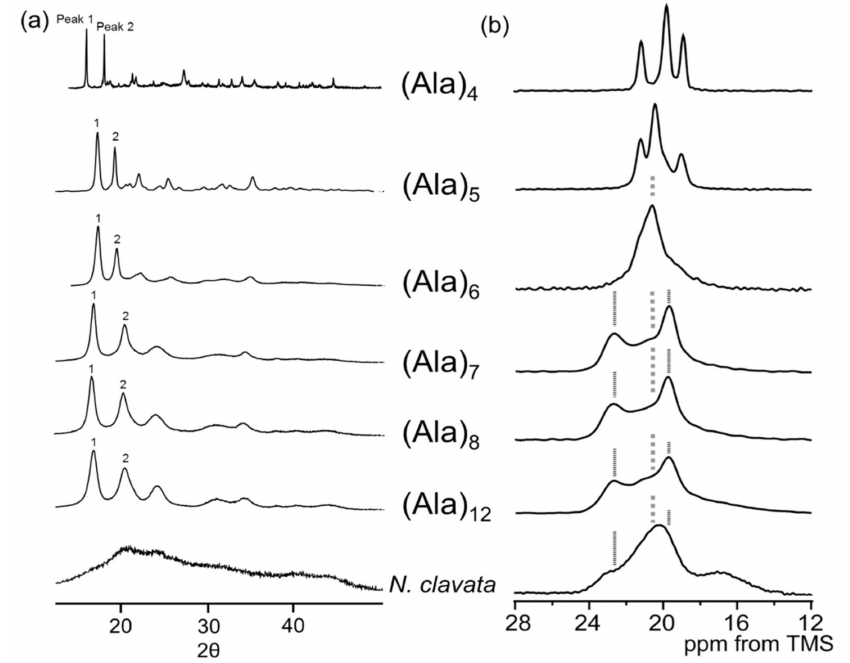
Figure 7. ( a ) X-ray di ff raction patterns and ( b ) Ala C β peaks in the 13 C CP / MAS NMR spectra of alanine oligopeptides, (Ala) n (n = 4 − 8 and 12), together with those of N. clavata dragline silk fibers